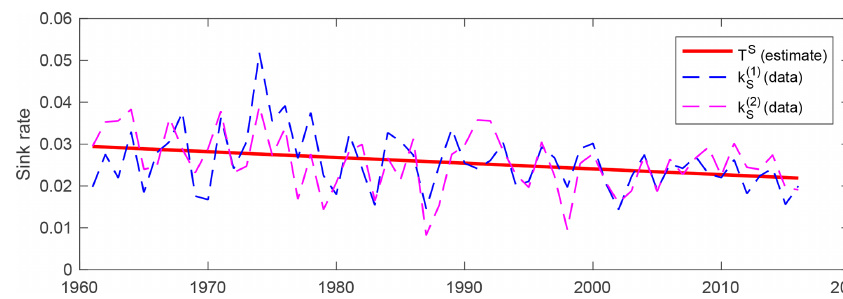
Figure 2. Estimated trend T S t of the CO 2 sink rate from Model (Eq. 15).